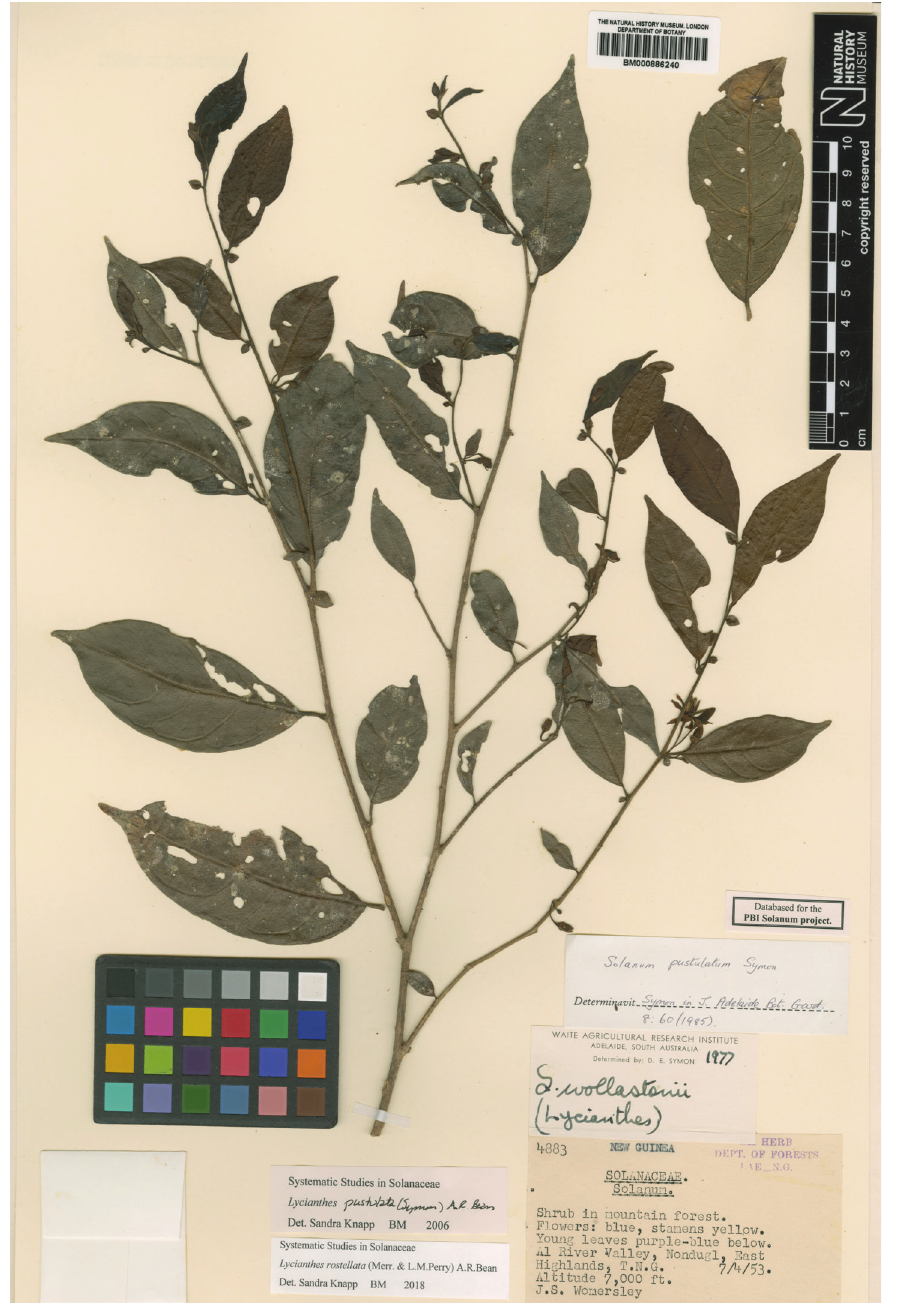
Figure 46. Lycianthes rostellata herbarium specimen. Papua New Guinea. Eastern Highlands: Womersley 4883 (BM000886240). Courtesy of the Trustees of the Natural History Museum, London, reproduced with